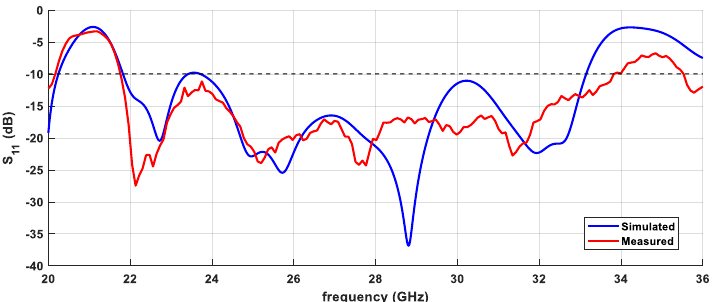
Figure 11. Simulated and measured reflection coefficient of the 9 elements antenna array. The radiation pattern at different frequencies, 27 GHz, 28 GHz and 29 GHz is shown in Figure 12. As with the other structures, it maintains a good agreement between simulations and measurements, clearly identifying and defining the main radiation lobe.